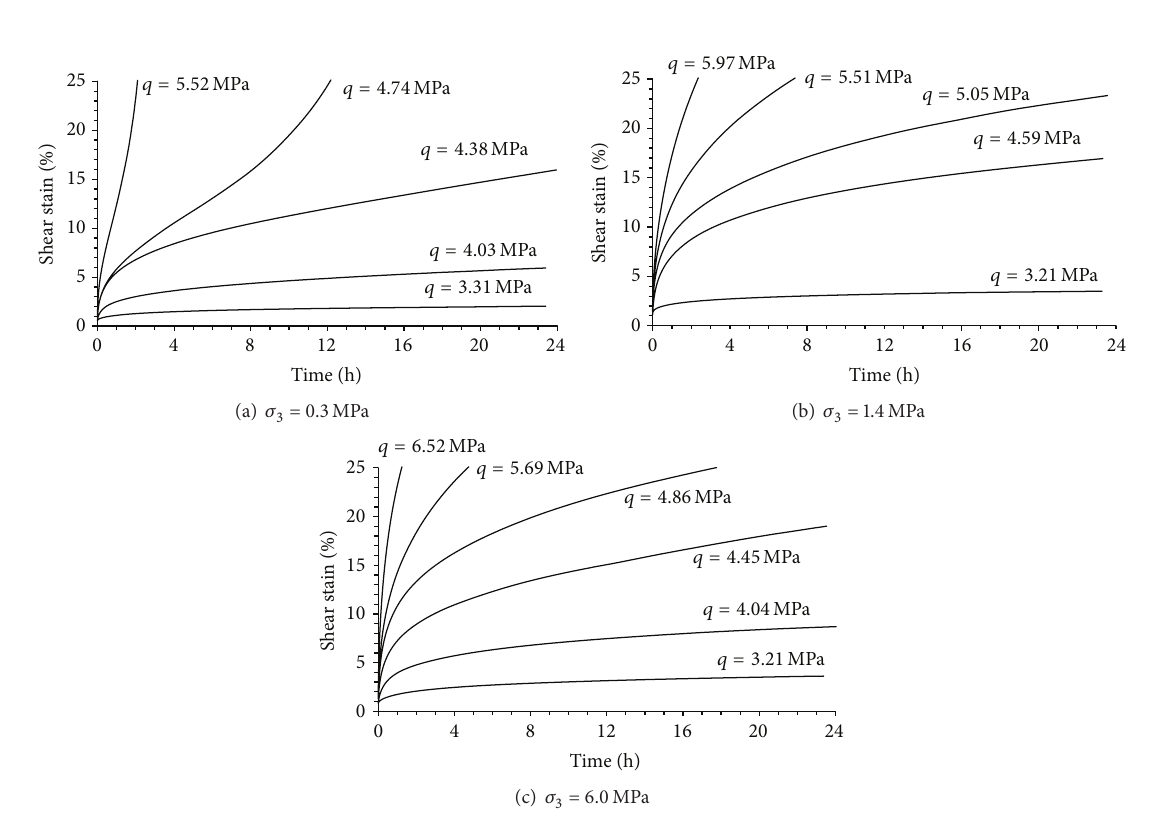
Figure 3: Creep curves under different confining